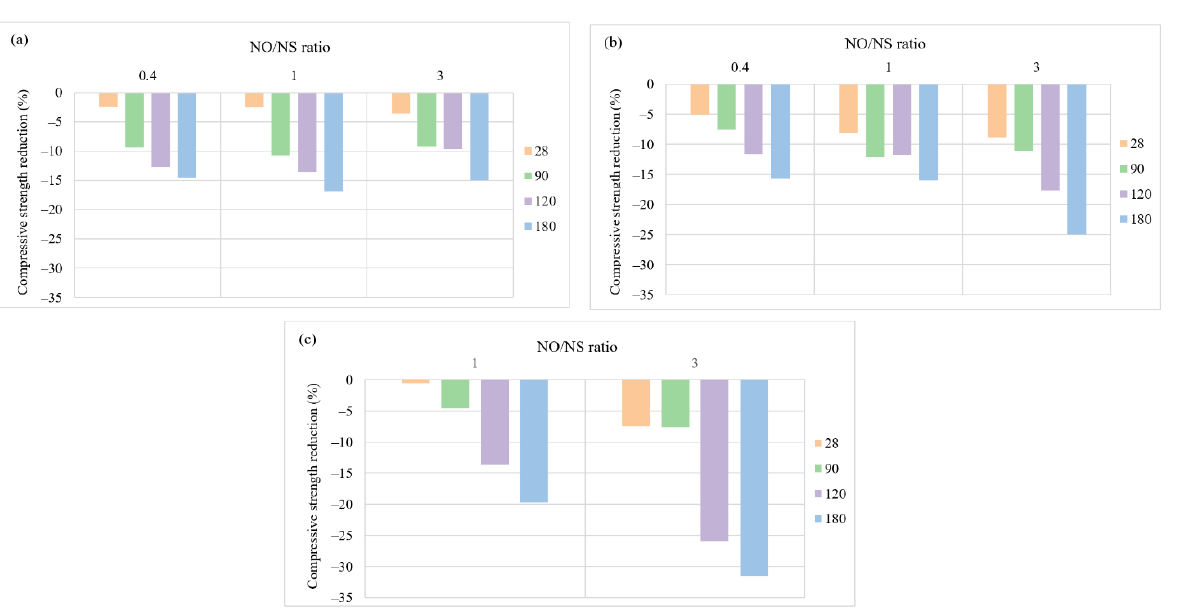
Figure 9. The effects of NO/NS ratios on weight loss at a molarity of ( a ) 6, ( b ) 10, and ( c ) 14.